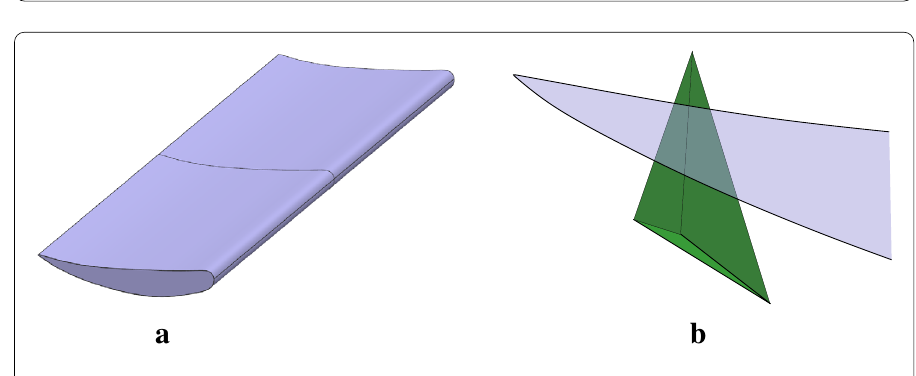
a b Fig. 21 Problematic intersection pattern with the approximation of a wing in a background mesh. a Wing model. b Element with several immersed boundaries at the sharp edge of the